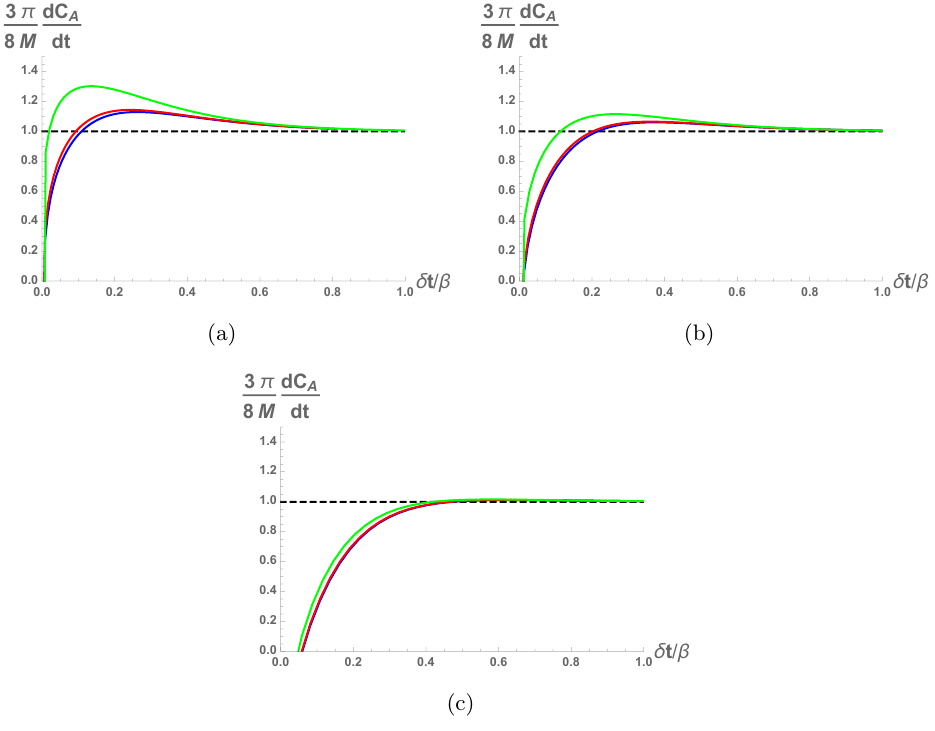
Figure 2 . dC A is plotted against the dimensionless quantity (cid:14)t=(cid:12) for d = 4 and n = 1. Here (cid:12) dt is inverse temperature. Panel (a) shows the variation of dC A (c) for r h = 3 : 5. In each panel blue, red and green curves correspond to a = 0 : 05, a = 0 : 1 and a = 0 : 5 respectively. In all cases, the dotted line represents the ratio 3 (cid:25) the constants c; (cid:22) c = 1 have been set for